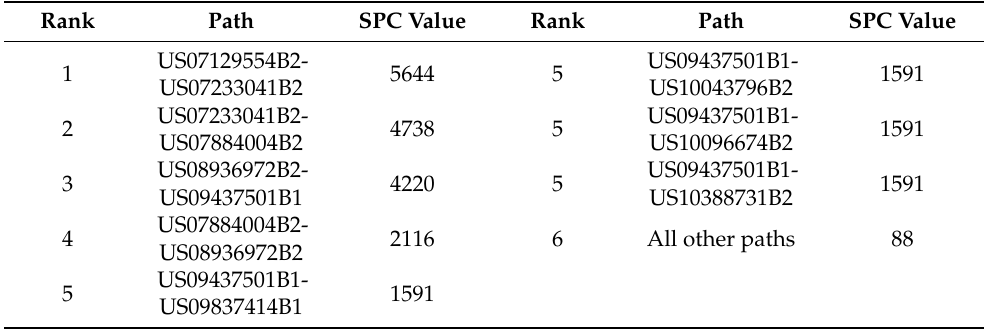
Table 7. SPC values associated with the